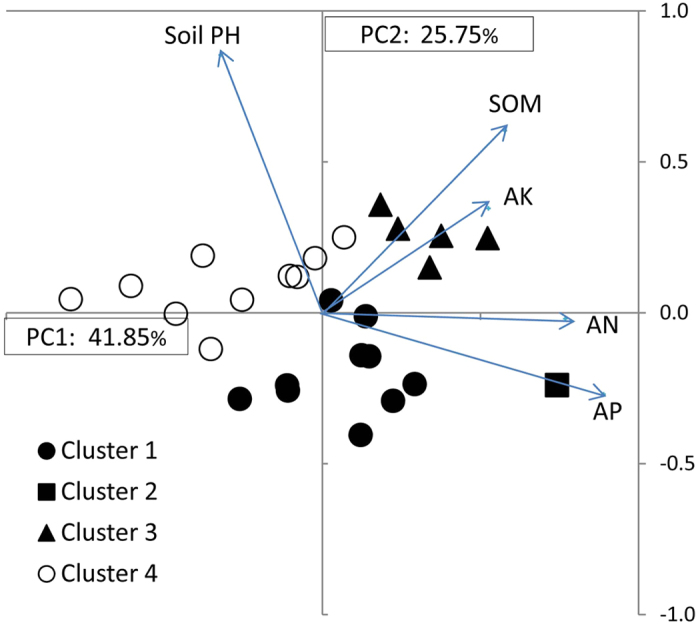
Principal components analysis of 26 soil samples of the pea production areas.Variable factor loadings for PC1 and PC2 are soil pH and soil nutrient variables and presented as vectors.